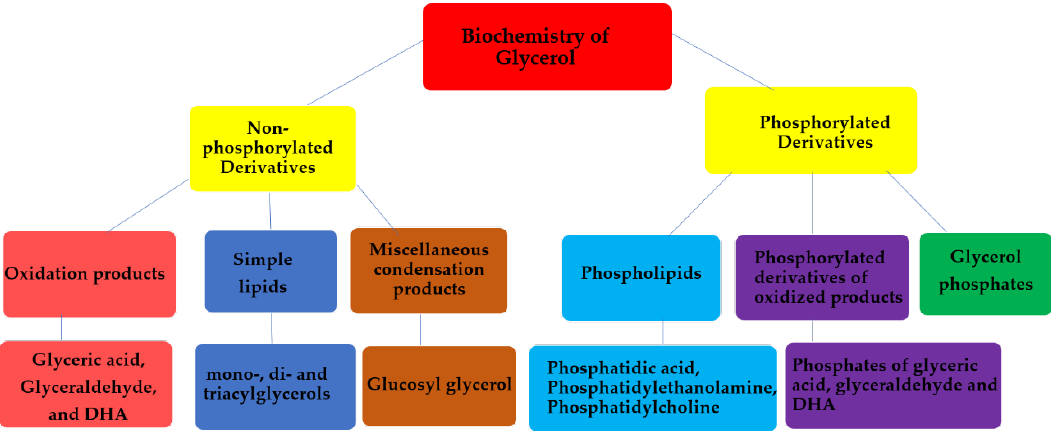
Figure 1. Flowsheet diagram of the important derivatives of glycerol that play important roles in biochemistry.